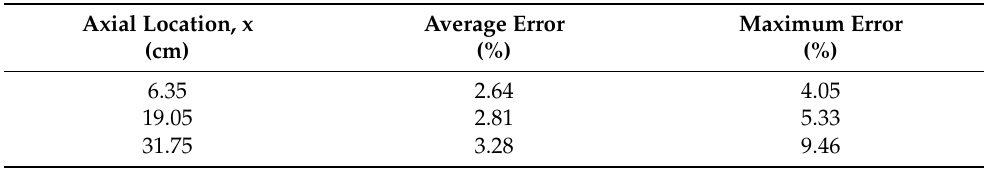
Table 3. Percentage error between the EPS models’ predicted and experimental temperatures at an air speed of 2.50